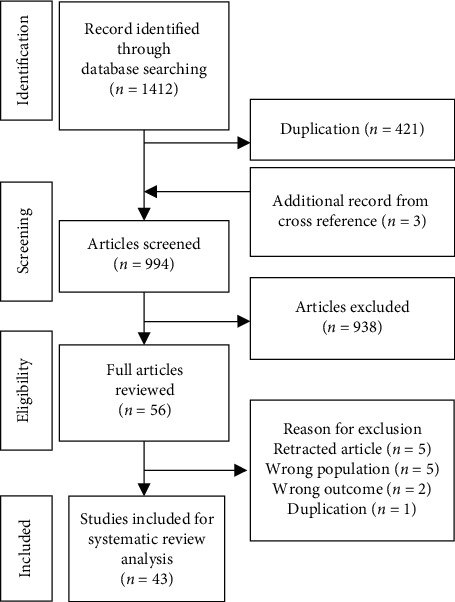
Flowchart of study search, screening, and selection.